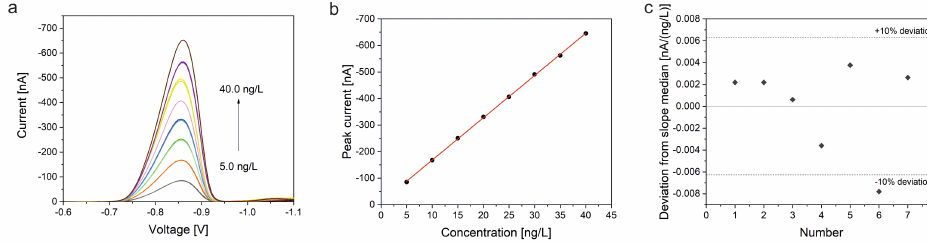
Figure 3. ( a ) Recorded HMDE voltammograms of different platinum standard solutions. ( b ) Resulting calibration curve with linear regression (red line) (after subtraction of blank values). ( c ) Results of the point-to-point gradient linearity test of the linear calibration